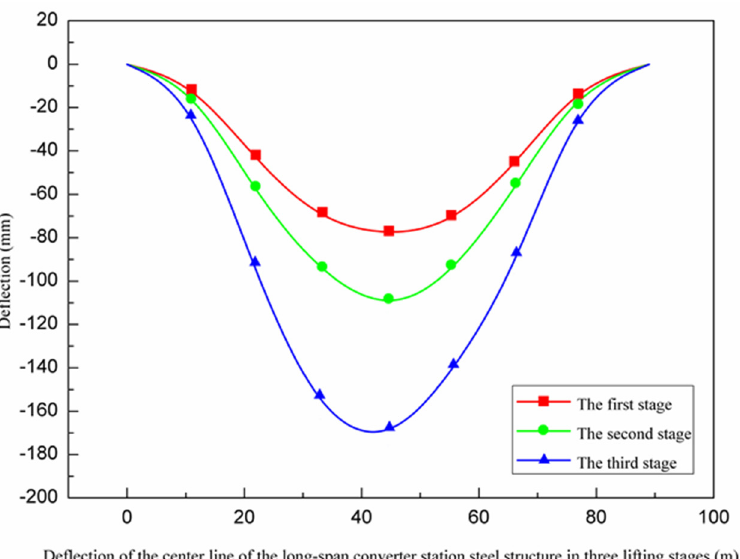
Figure 25. Deflection of the centerline of the long − span converter station steel structure in three lifting stages.